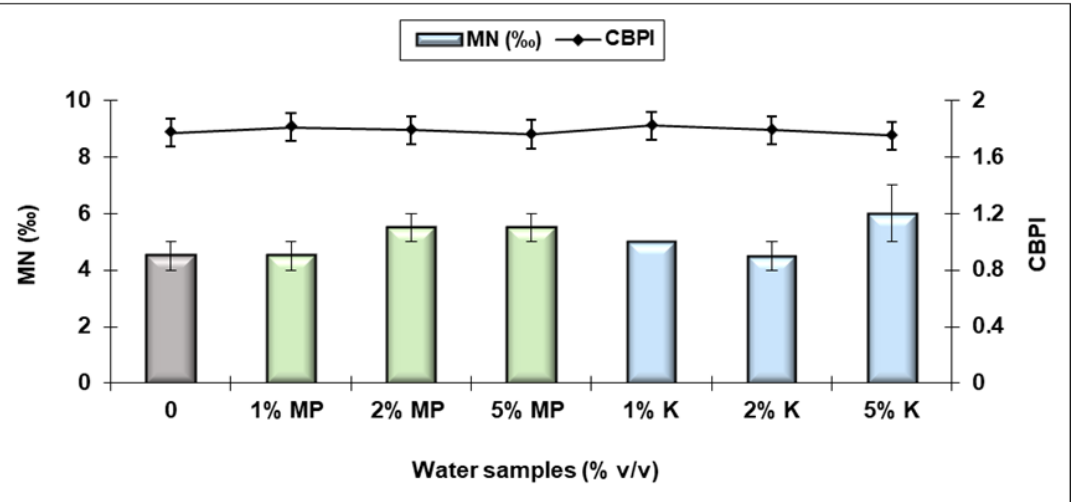
Figure 5. Frequencies of MN (histograms) and CBPI values (solid black line) in cultured human lymphocytes treated with different concentrations of surface water (1, 2, and 5%, v / v ) from Mikri Prespa (MP) and Kastoria (K) lakes (S2). MN, micronuclei; CBPI, cytokinesis-block proliferation index; mean MN frequencies, expressed as number of MN (‰) ± standard error per 2.000 binucleated cells per experimental point; mean CBPI values, expressed as number of CBPI ± standard error per 1.000 binucleated cells per experimental point [G-test for MN; χ 2 for CBPI].